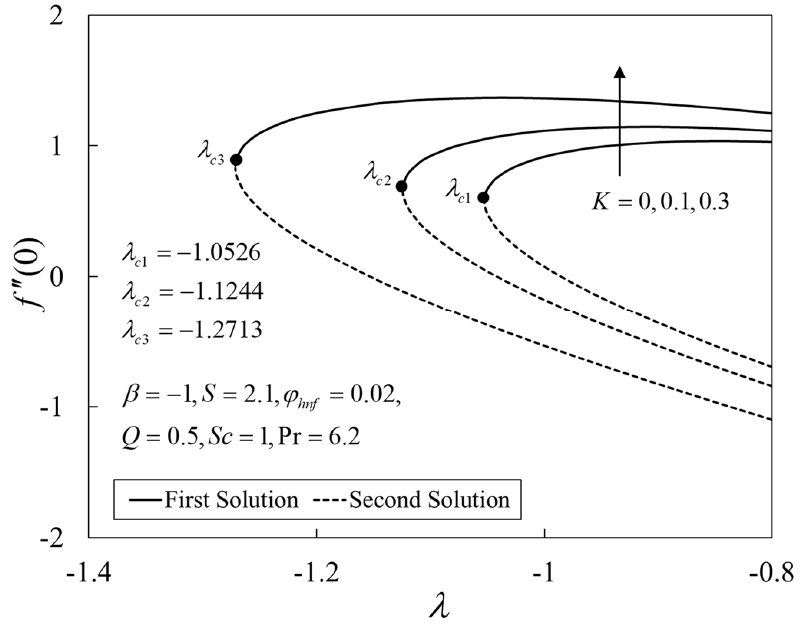
Figure 9. Plot of (0) f  against  . Figure 9. Plot of f (cid:48)(cid:48) ( 0 ) against λ